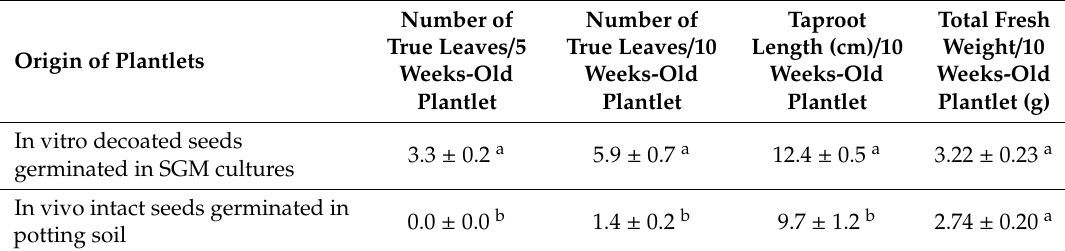
Table 4. Growth performance of M. autumnalis plantlets developed from decoated seed cultures vs. intact seeds directly sown in potting soil *.